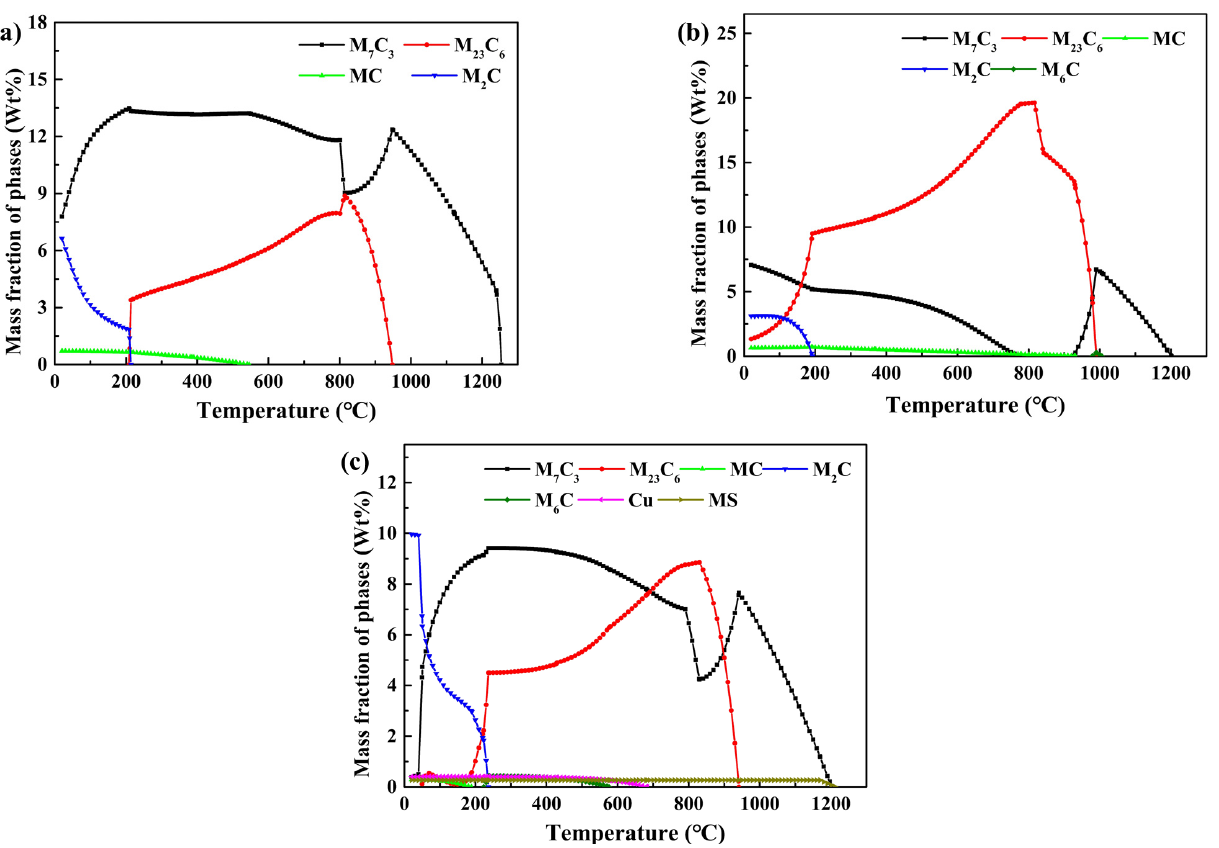
Figure 3. Calculation of equilibrium phase content with temperature: ( a ) SKD11; ( b ) DC53; ( c ) SLD- MAGIC.